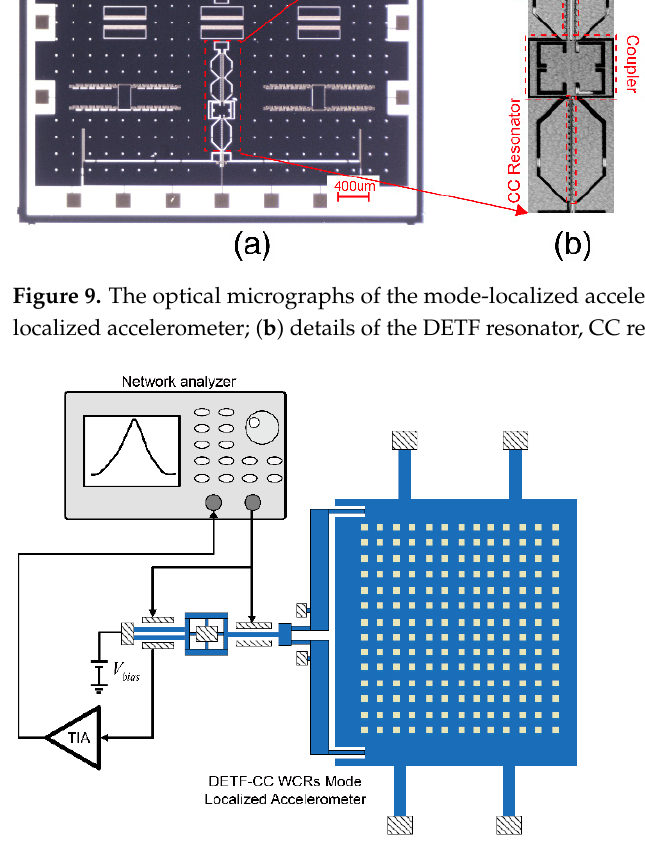
Figure 10. Open-loop experimental setup of the DETF-CC accelerometer.